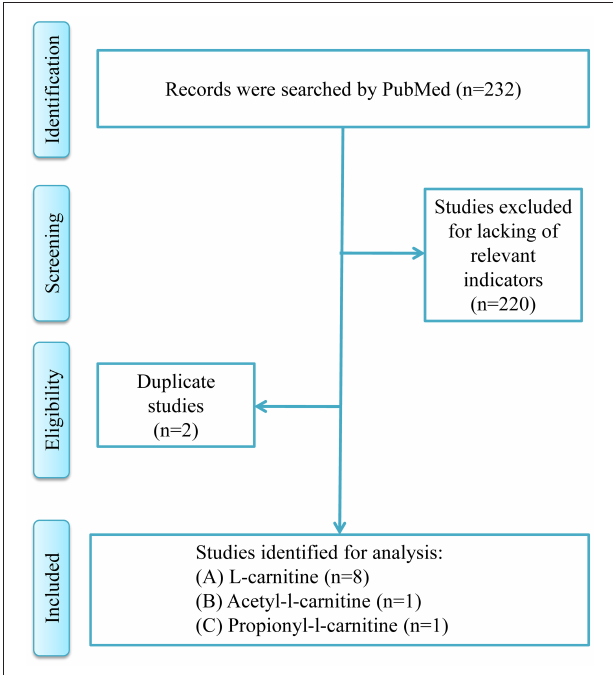
FIGURE 1 | Overview of the strategy for literature review.